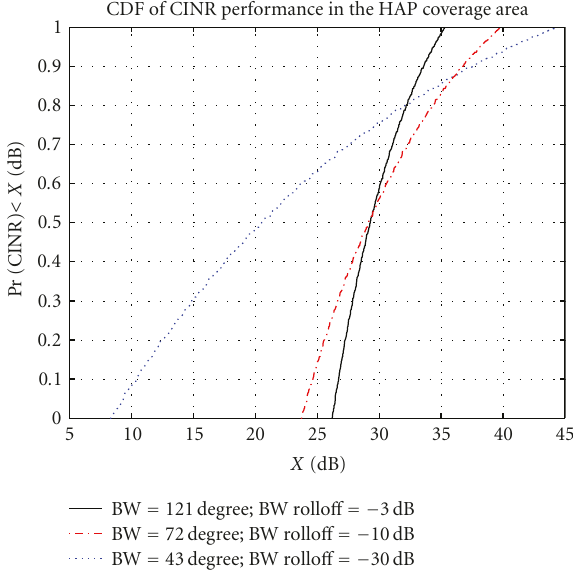
Figure 9: CINR H performance under di ff erent HAP antenna